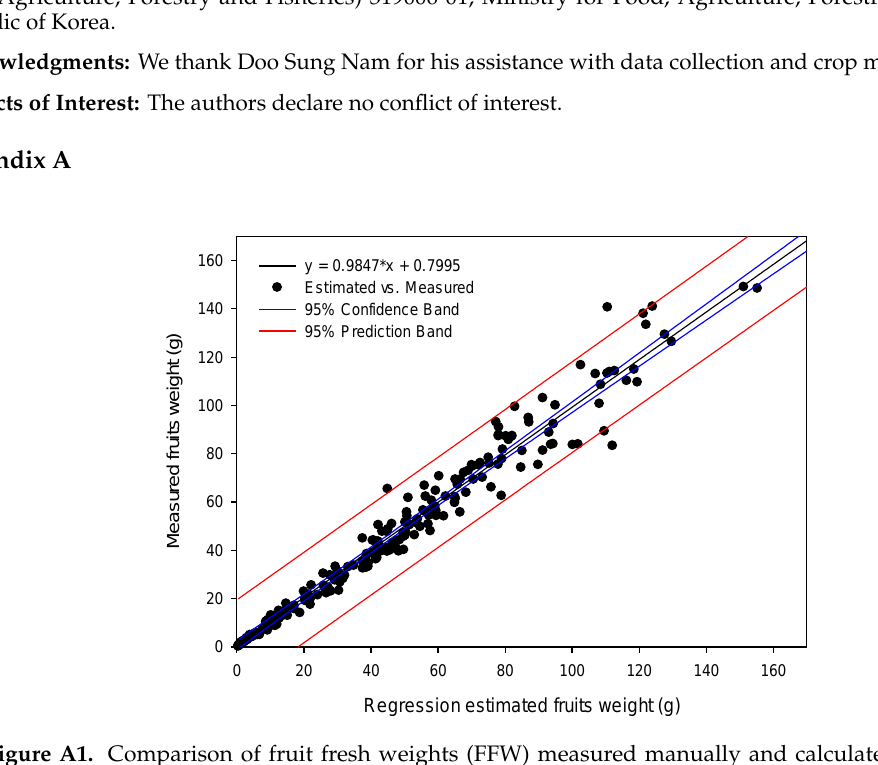
Figure A1. Comparison of fruit fresh weights (FFW) measured manually and calculated with an estimation regression of fruit length (LF) and fruit diameter (WF). FFW = 290.74 ∗ WF 2 ∗ LF + 0.342.